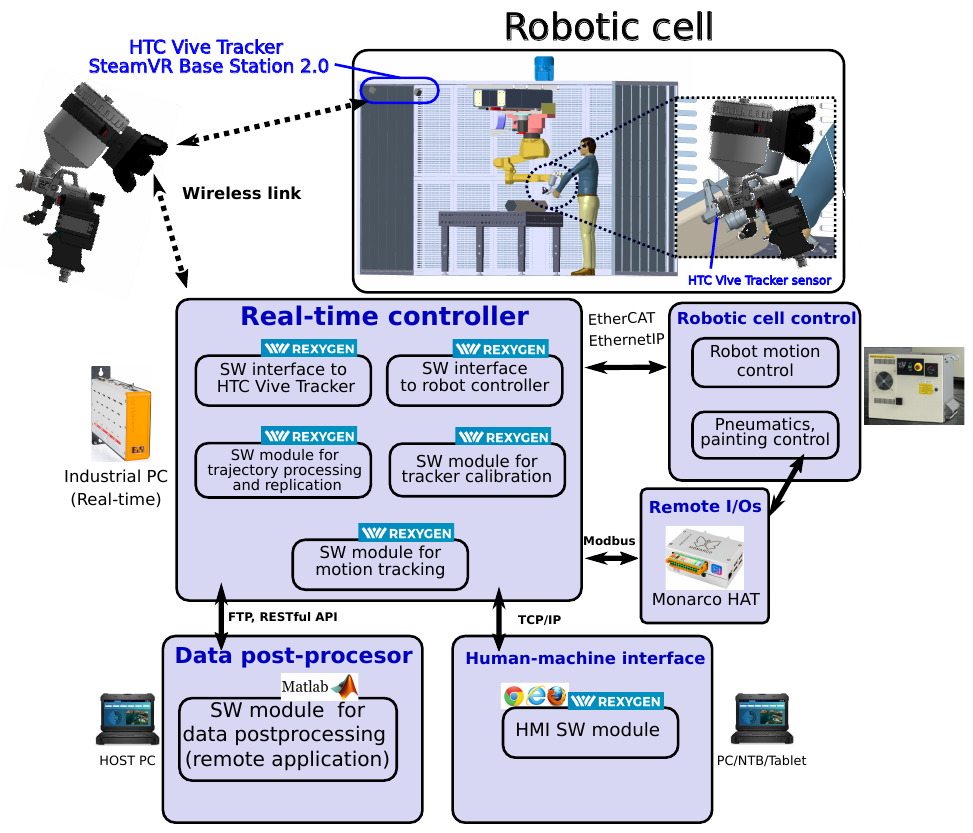
Figure 1. Overall conception of a robotic cell equipped with the motion tracking